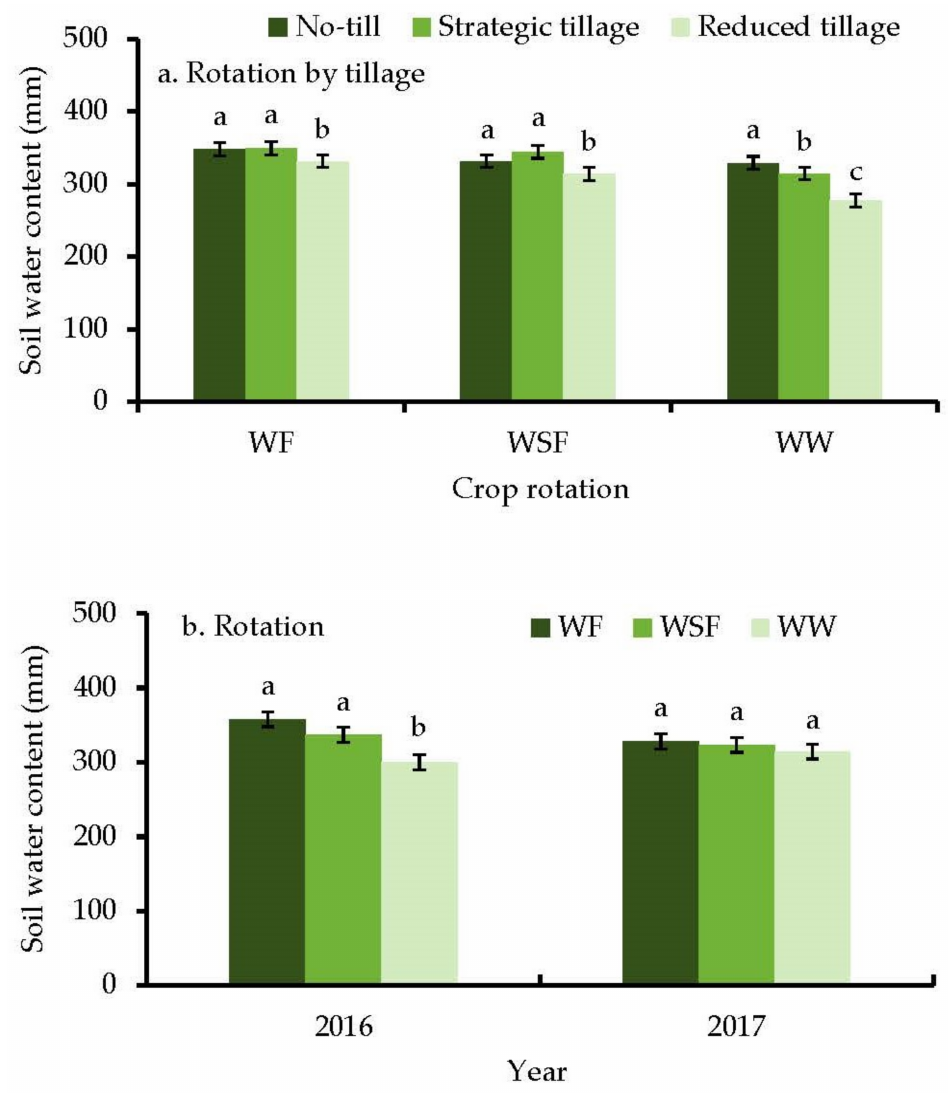
Figure 2. Soil water content at winter wheat planting as influenced by ( a ) tillage × crop rotation and ( b ) crop rotation at sowing time of wheat in 2016 and 2017. Means followed by the same lower-case letter(s) within crop rotation or year are not significantly different using the least squares means (LSMEANS) and adjusted Tukey multiple comparison procedure ( p > 0.05). WF =